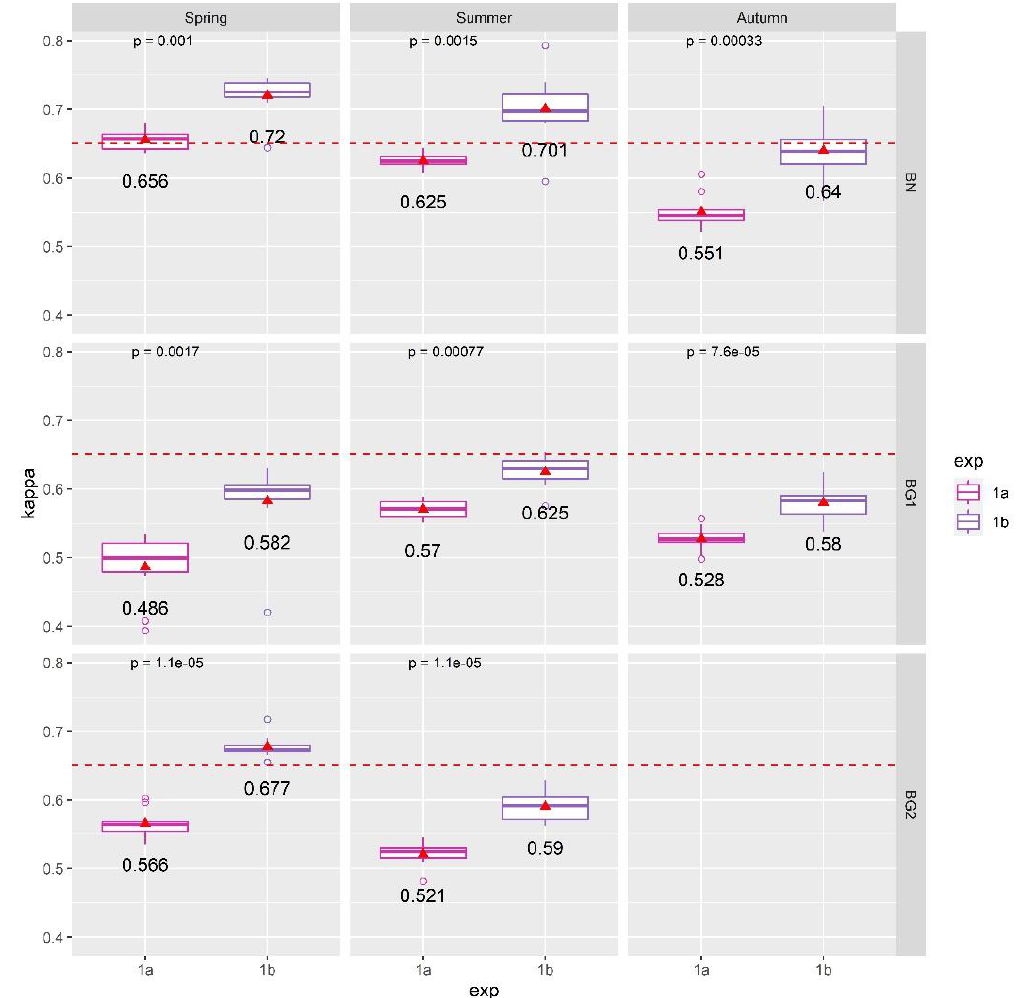
Figure 8. K accuracies obtained by classifying the 430 SR bands with RF-RFE (Exp. 1a) and the 30 minimum noise fraction (MNF) components with RF (Exp. 1b). p-values resulting from the Wilcoxon test comparisons are displayed. Red triangles represent the mean K values (also written). Boxplots show the median, the lower and upper hinges corresponding to the first and third quartiles; the upper and the lower whiskers are the 1.5 · interquartile range. Red dotted lines represent a confidence level of K = 0.65.